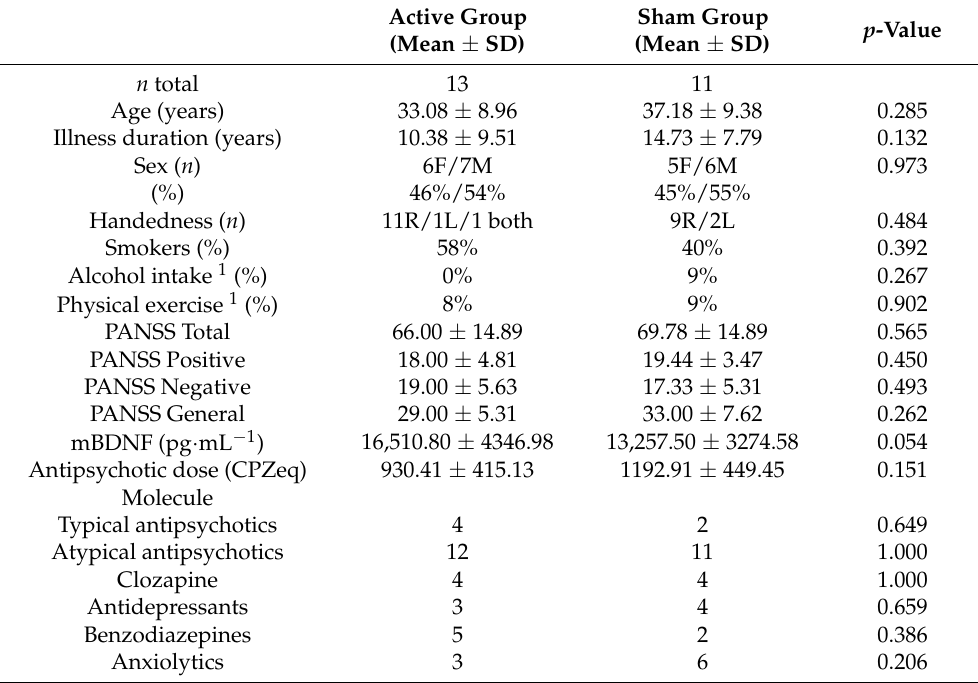
Table 1. Baseline sociodemographic and clinical data of participants in active and sham